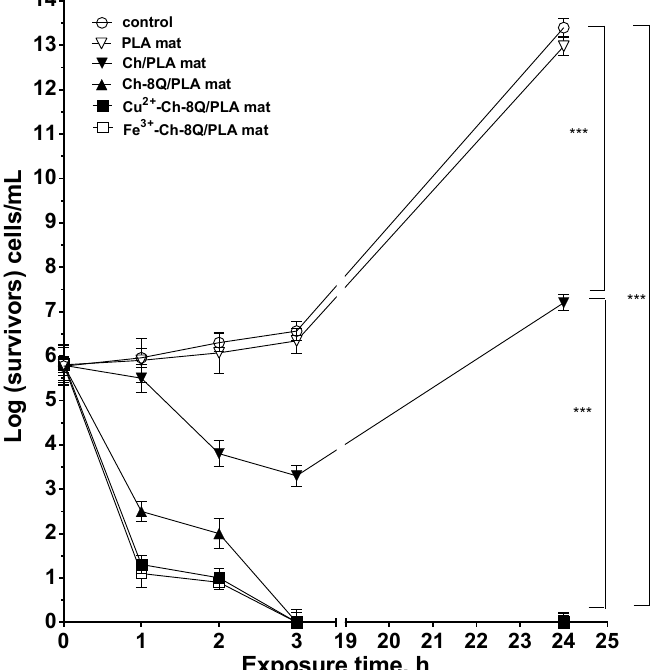
Figure 9. Logarithmic plot of the viable bacterial cell S. aureus number versus the exposure time for control ( S. aureus ), PLA mat, Ch/PLA mat, Ch-8Q/PLA mat, Cu 2+ complex of Ch-8Q/PLA mat and Fe 3+ complex of Ch-8Q/PLA mat. Data represent the mean ± standard deviation ( n = 3). *** p < 0.001, statistical significance.